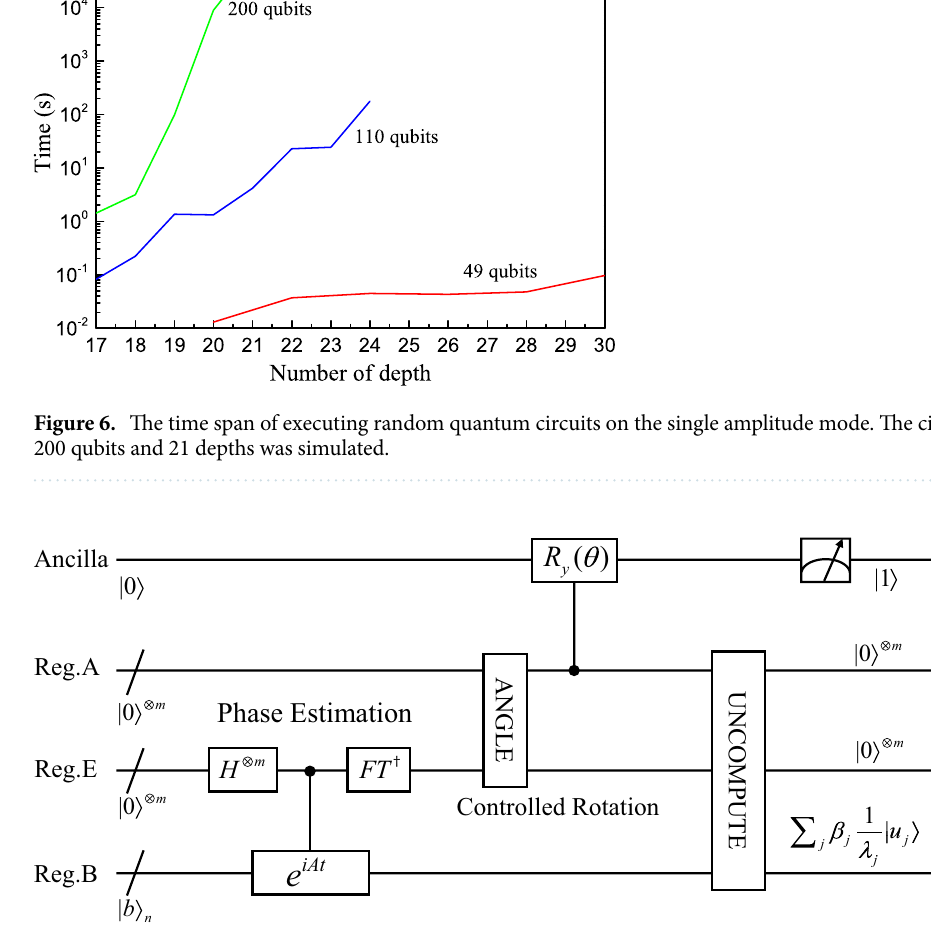
Figure 7. The overall quantum circuit of the quantum fast Poisson solver. It has four main registers, i.e. register B, E, A and Ancilla. Register B is used to encode the coefficients of Poisson equation. It is the input of the circuit. The approximated eigenvalues are stored in register E. Register A is used to store angles for the controlled rotation operation. The Ancilla register will transduce the reciprocals of eigenvalues to the